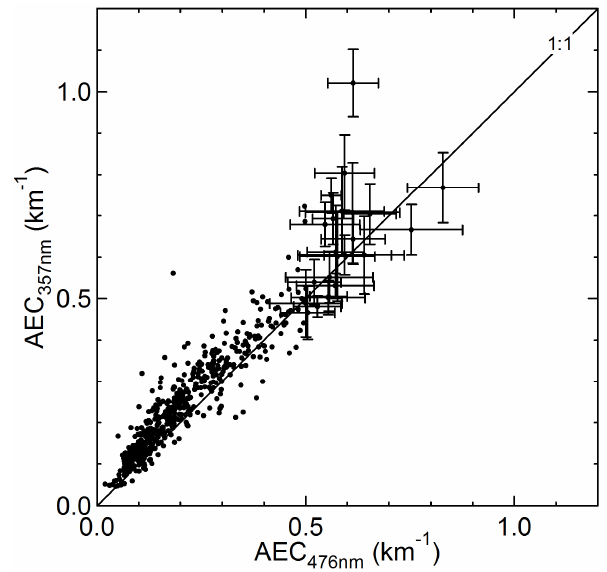
Fig. 7. Correlations between MAX-DOAS AECs at 357 and 476 nm for the 0-1 km layer. Error bars representing random errors are shown only for large values for clarity.